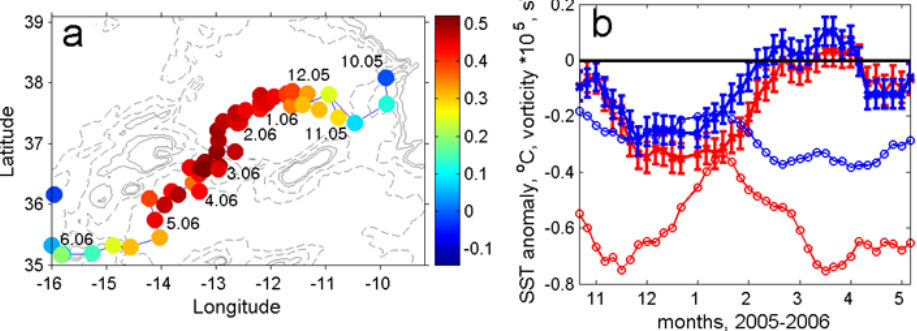
Fig. 8. (a) Mean salinity anomalies relative to WOA09 climatic data in the 700–1500-m layer for the consequent Argo vertical profiles (anomalies over 0.3 were identified as Meddy 2). Thin grey contours show bottom topography with a 1000-m interval. (b) Monthly running means of SST 25 –SST 100 ( ◦ C, red lines with errorbars) and relative vorticity in the 25-km central ring (10 − 5 s − 1 , thin red lines with circles). The respective blue lines are SST 50 –SST 100 and mean relative vorticity in the 25–50-km ring around the centre of the meddy surface signal. The errorbars represent the mean error in the calculation of the SST